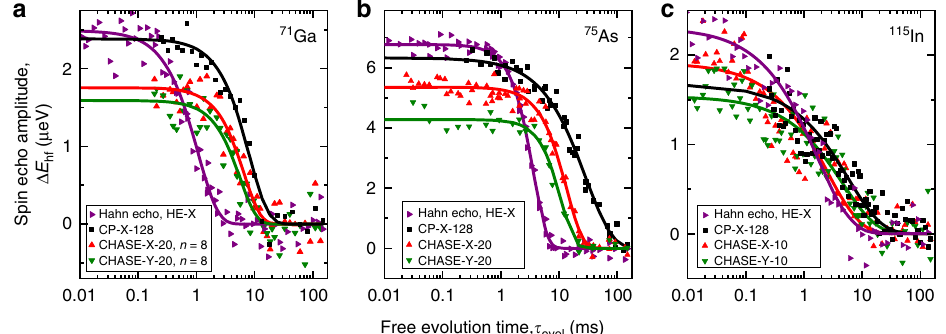
Fig. 2 Nuclear spin echoes in a single neutral InGaAs QD. a Decay of the 71 Ga NMR spin echo measured via hyper fi ne shift Δ E hf as a function of the total free evolution time τ evol under different control sequences. Symbols mark experimental data and solid lines show best fi ts with Eq. (3). b , c Results for 75 As and 115 In, respectively